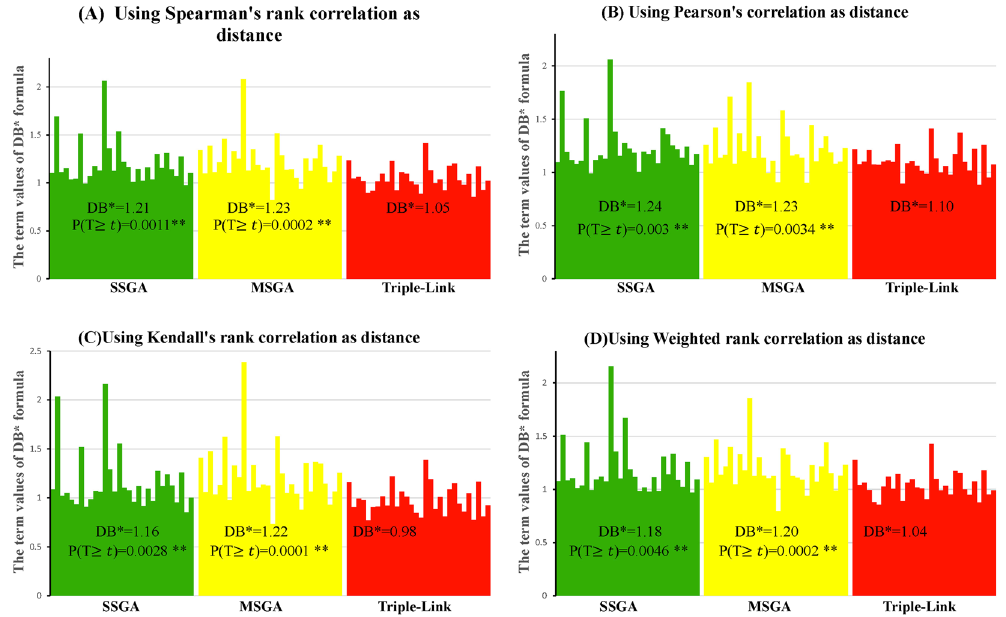
Figure 6. Davies-Bouldin * (DB * ) indices for SSGA, MSGA and Triple-Link Algorithm, and the term scores of DB formula calculated for each of 30 subnetwork is represented by 30 bars. The distances used for calculating DB * were based on Spearman’s rank correlation ( A ); Pearson correlation ( B ); Kendall’s rank correlation ( C ); Weighted rank correlation ( D ). In all the cases, the higher DB * term scores or the DB * indices, the tighter the internal coordination of derived subnetworks. The Student’s t-test (unpaired) was performed to examine the difference between DB * ’s term scores of 30 SSGA-/MSGA-derived subnetworks and DB * ’s 30 term scores of 30 Triple-Link Algorithm-derived subnetworks. The difference is significant if P( T ≥ t ) < 0.05 .